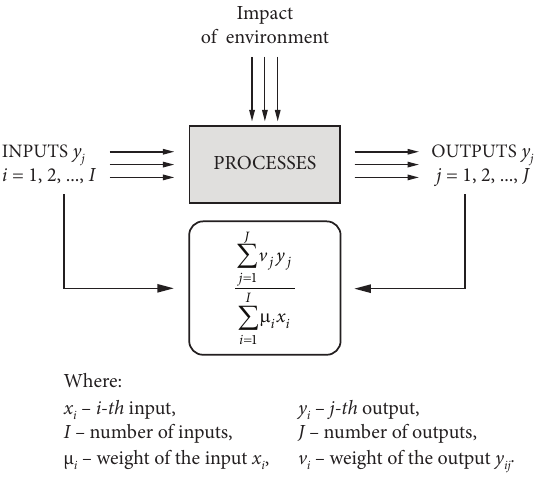
Fig. 1. Concept of the DEA